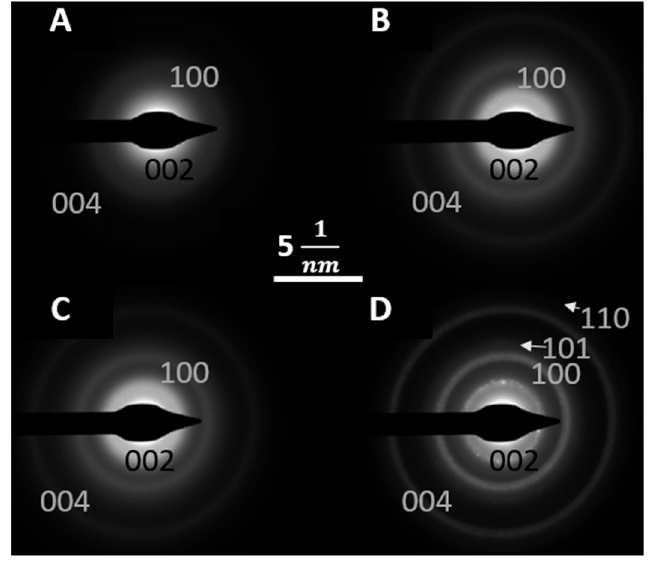
Figure A12. SAED patterns from sucrose char ( A ) virgin ( B ) after annealing at 2600 °C for 1 s ( C ) after annealing at 2600 °C for 5 s and ( D ) after annealing at 2600 °C for 10 s.